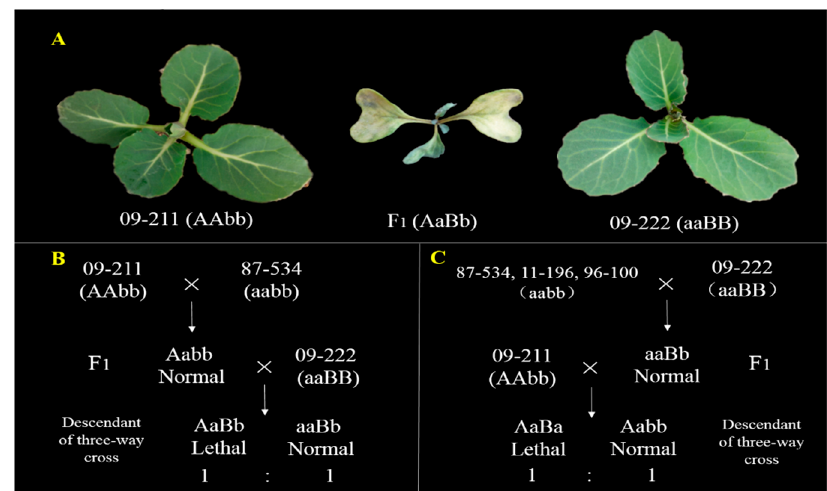
Figure 1. Phenotypes of the parental lines and F 1 hybrids and the segregating population strategy. ( A ) Phenotypes of the parental lines 09-211 and 09-222 and the F 1 hybrids; ( B ) Segregating population strategies used to map BoHL1 ; ( C ) Segregating population strategies used to map BoHL2.